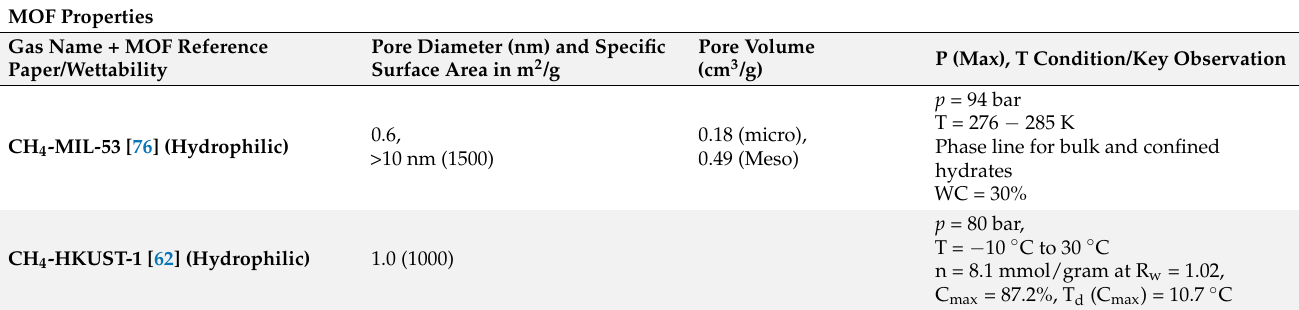
Table 2. Available research on MOF–hydrate synergy for CH 4 storage (n = maximum CH 4 stored in H 2 O system in mmol/g, R w = ratio of water/MOF (g/g), C max = Maximum water to hydrate conversion %, T d = dissociation temperature at C max, WC = water content